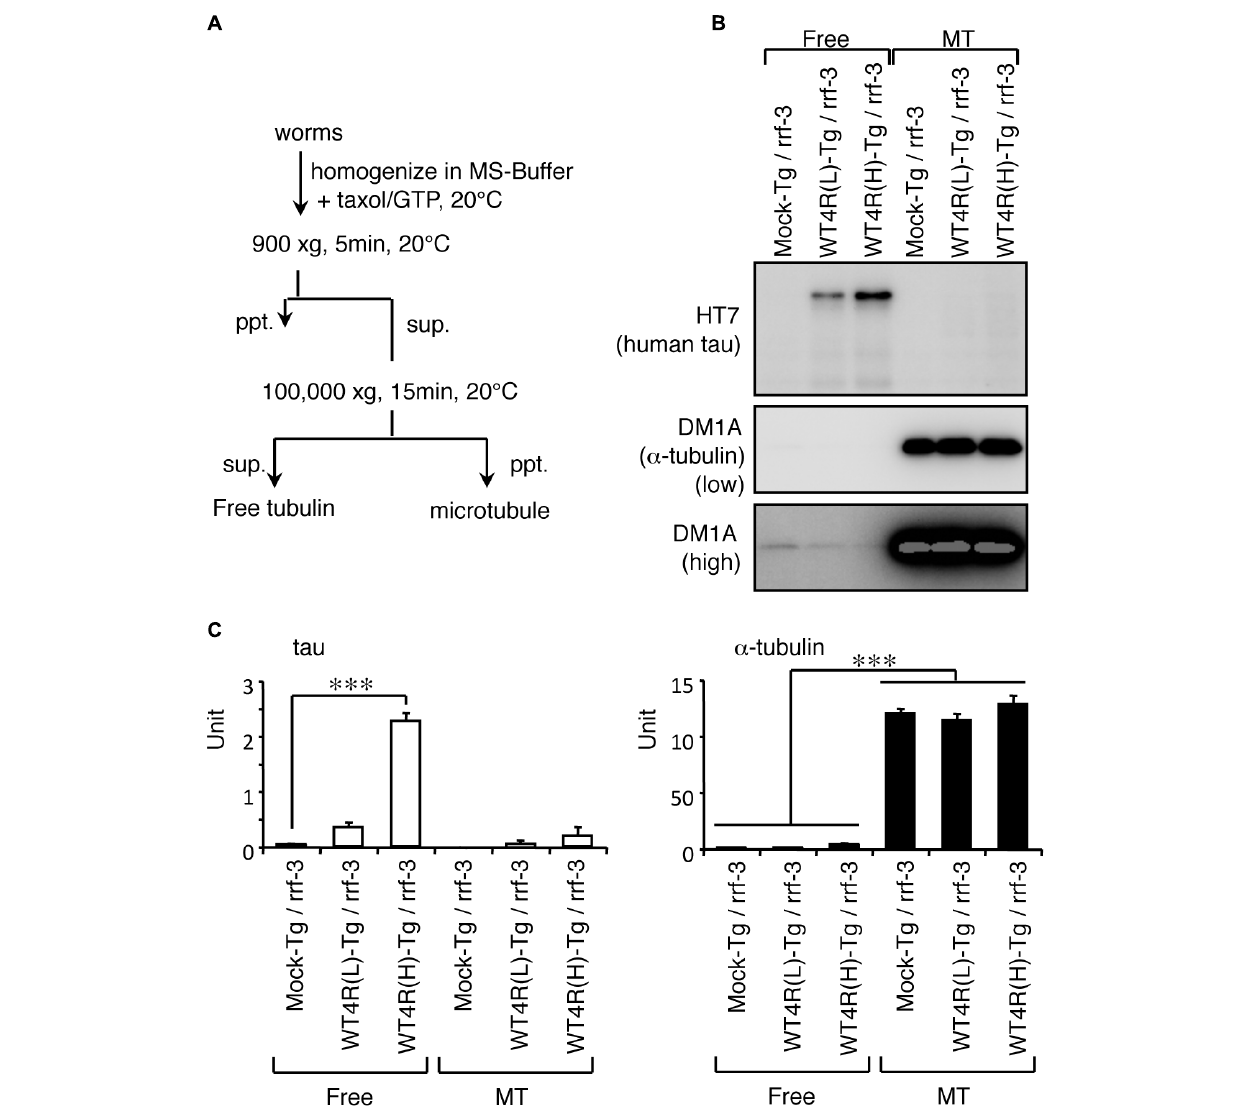
FIGURE 5 | Human-tau in punc-119::tau worms are not bound to MTs. (A) Flowchart of fractionation of MT and free tubulin fractions from worms are shown. (B) Western blotting of free tubulin (Free) and MT fractions from indicated worms using anti-tau (HT7) and anti- α -tubulin (DM1A) antibodies. (C) The amounts of tau and α -tubulin in Free and MT fractions were quantified (means ± SEM, n = 5). Statistical significance was analyzed by Tukey’s post hoc test ( ∗∗∗ p < 0.001 ).